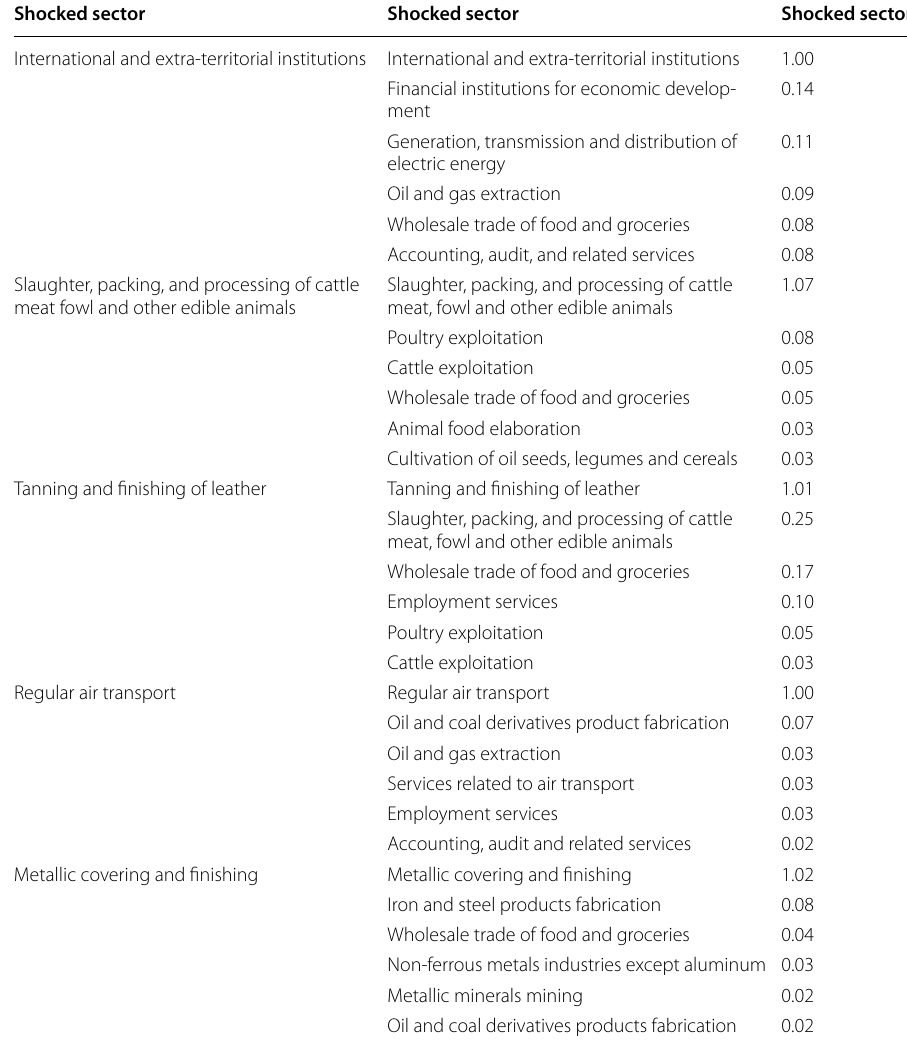
Table 5 Top ranked sectors according to aggregate effect and diffusion (2012). Source: Results from authors